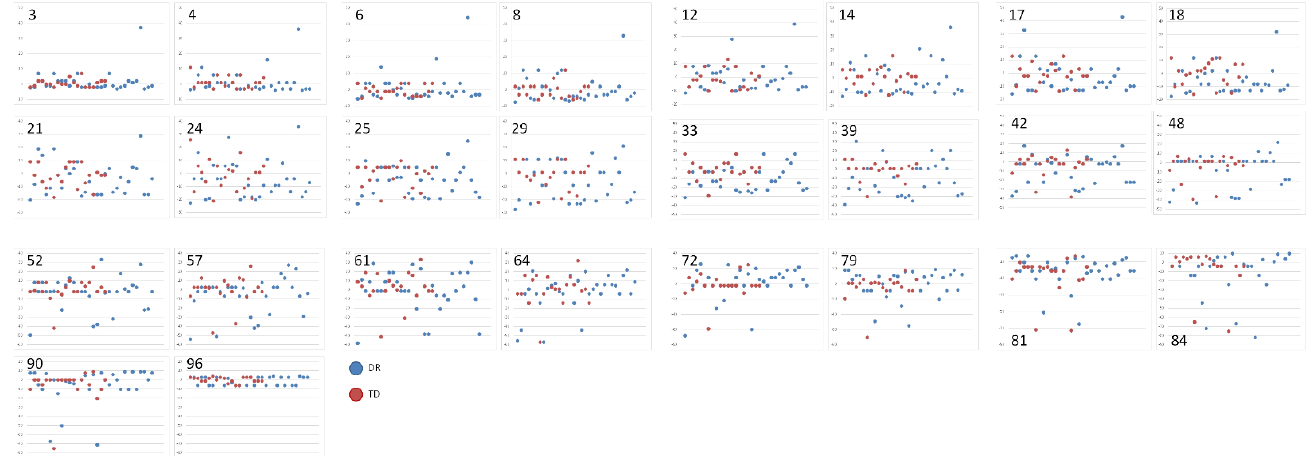
Figure 7. Scatter plots showing the mean EEs calculated for each of 26 numbers used in the 0–100 verbal task and for each participant. In each plot presenting the results obtained for a particular number magnitude, the dispersion revealed in the DR group is presented in blue, and that in the TD group is presented in red .